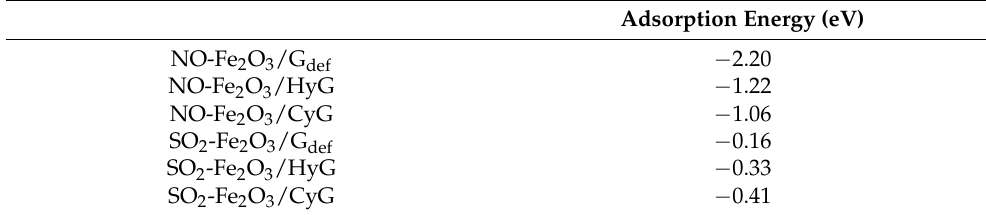
Table 1. E ads for NO [and SO 2 ] adsorption on Fe 2 O 3 /G def , Fe 2 O 3 /HyG, and Fe 2 O 3 /CyG.